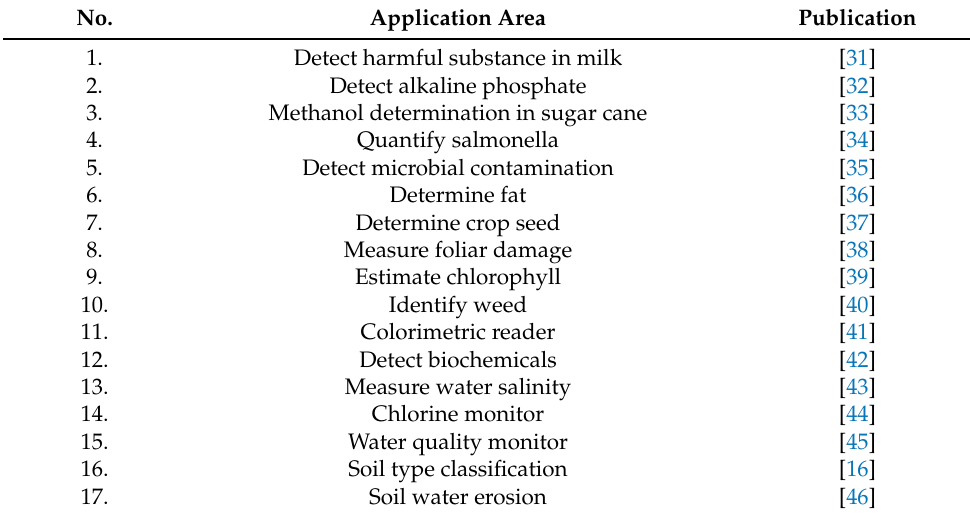
Table 1. List of research using smartphone